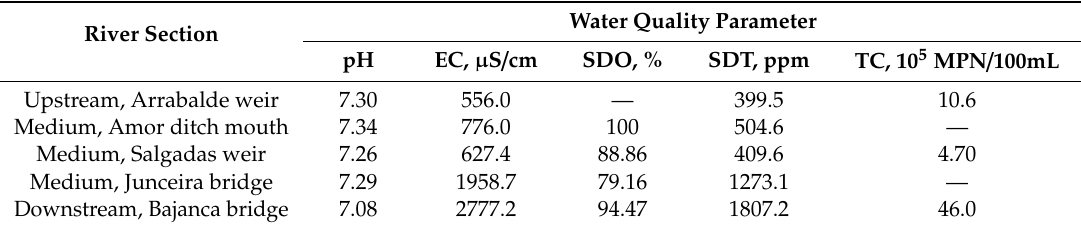
Table 5. Physicochemical and microbiological parameters of water sampled, at Lis river sections, in 2018, in LVID (average values). Water Quality Parameter River Section pH EC, µ S / cm SDO, % SDT, ppm TC, 10 5 MPN / 100mL Upstream, Arrabalde weir 7.30 556.0 — 399.5 10.6 Medium, Amor ditch mouth 7.34 776.0 504.6 — Medium, Salgadas weir Medium, Junceira bridge — Downstream, Bajanca bridge